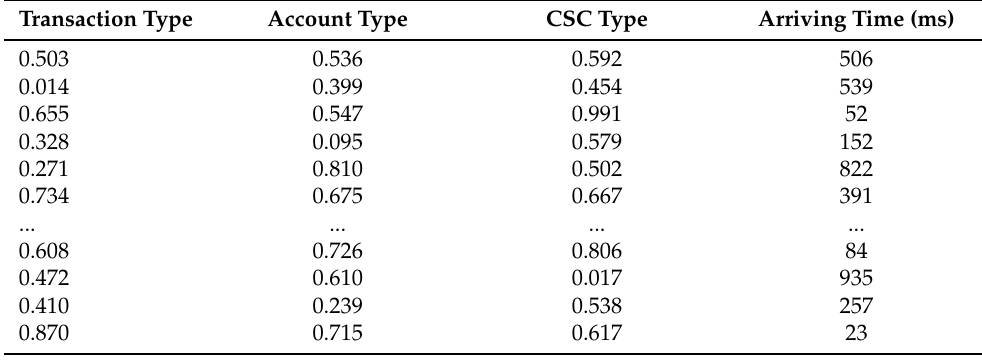
Table 8. Samples of transactions.